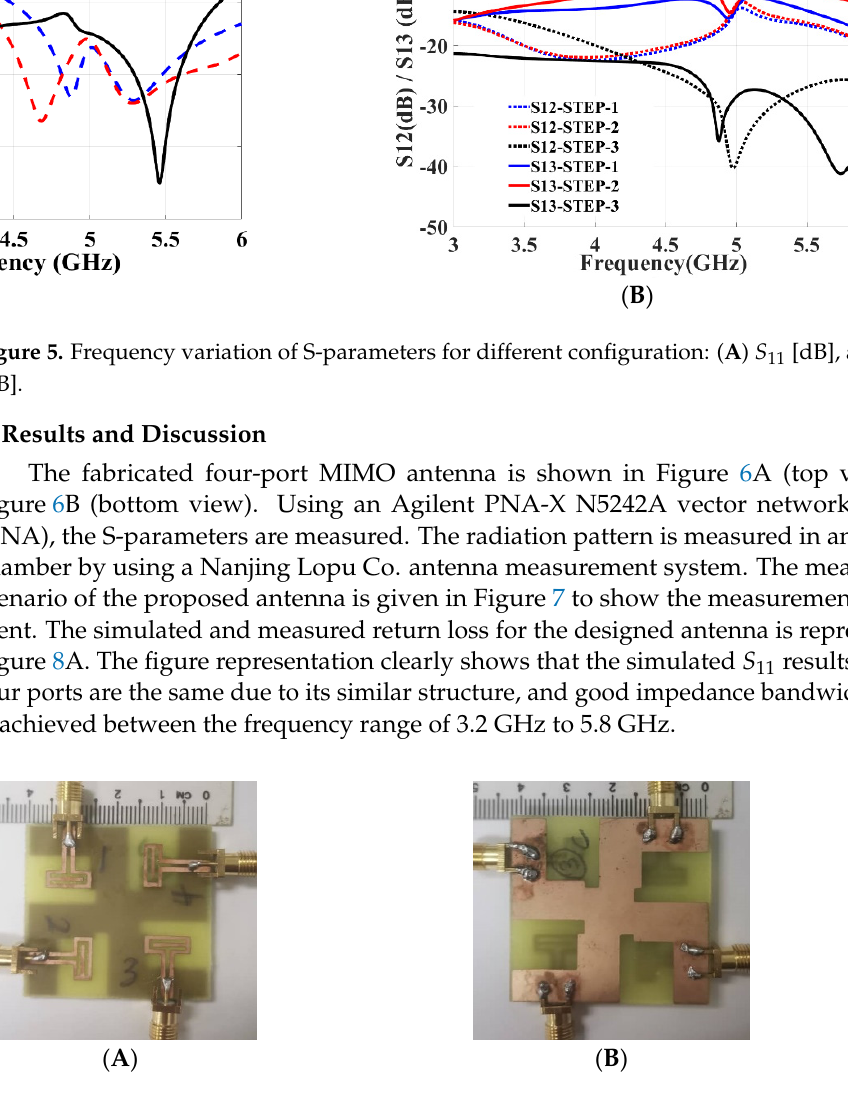
Figure 7. MIMO antenna measurement setup in an anechoic chamber. On the other side, measured return-loss results of the proposed antenna show utmost similar results with good bandwidth of 54% covering the frequency range from 3.2 GHz to 5.6 GHz. The measured return-loss results show a slight difference in the frequency range. This difference is primarily due the fabrication process and slight alteration in the dielectric constant of the substrate.